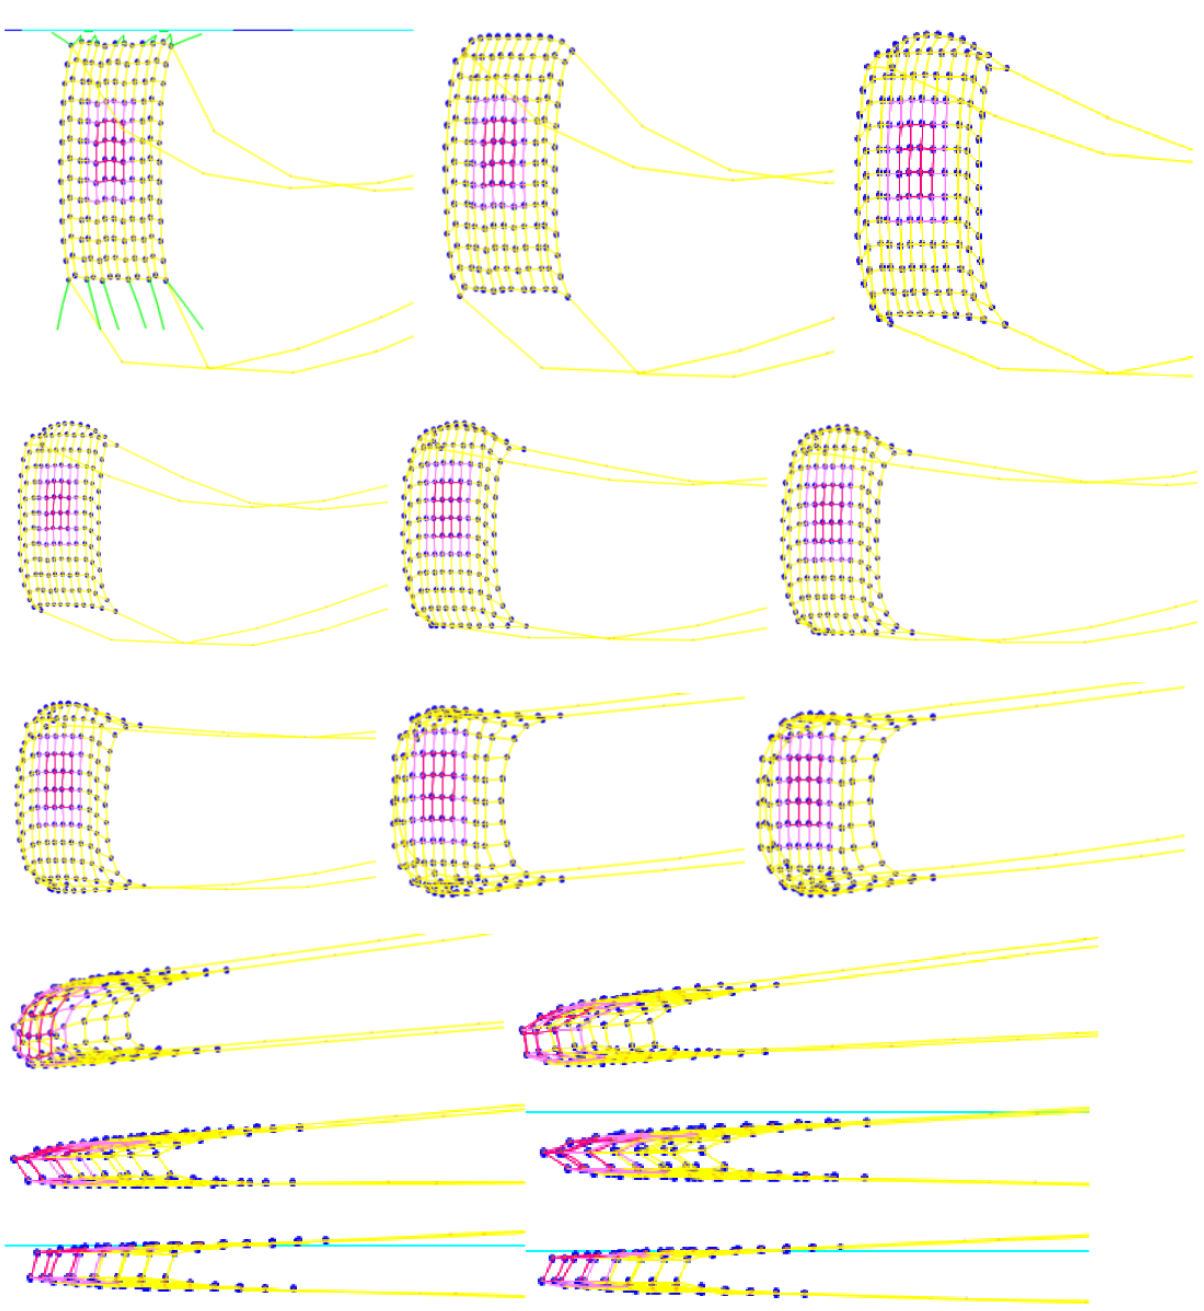
Figure 32. Shape changes of the flexible trawl in straight-line towing at v = 1 m/s.